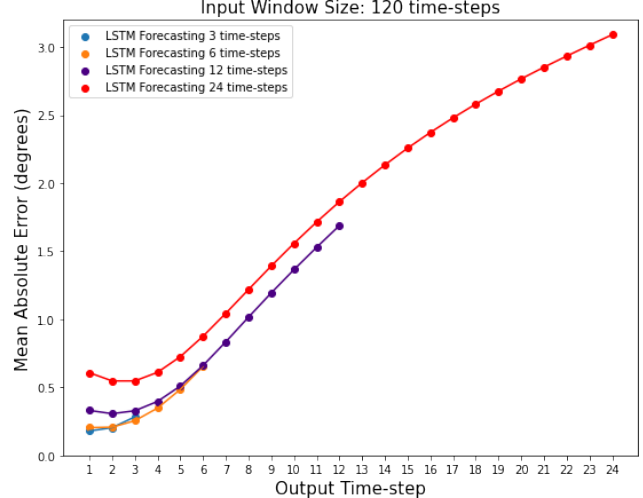
Figure 7. Mean absolute errors for each individual time-step predicted by the LSTM networks with 3, 6, 12, and 24 output window sizes. Input window size is fixed at 120 time-steps.